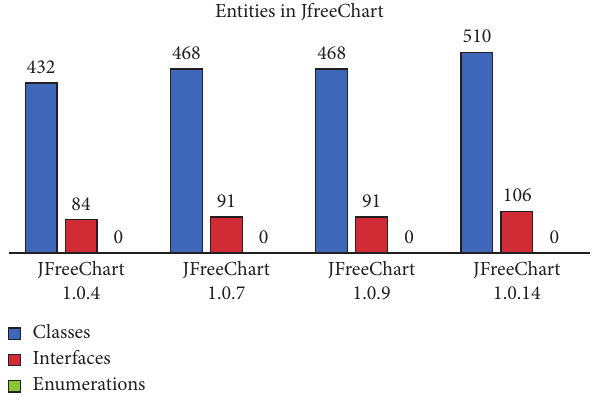
Figure 10: Count of entities in